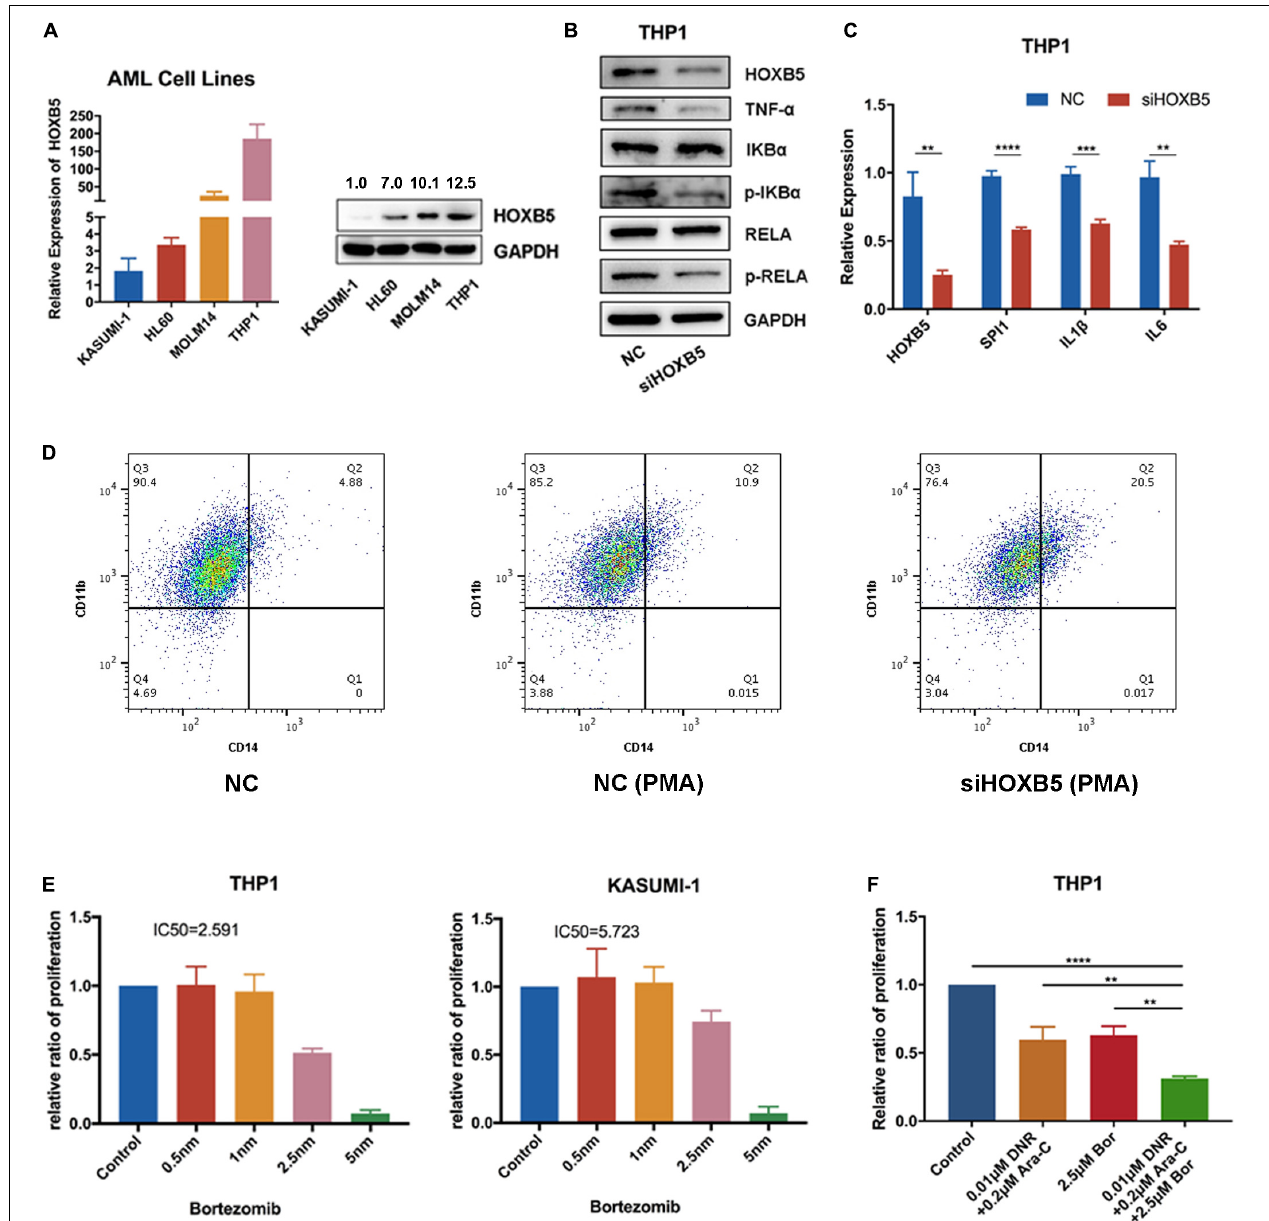
FIGURE 4 | HOXB5 participates in myeloid cells differentiation by regulating TNF/NF- κ B pathway. (A) HOXB5 expression differences in four AML cell lines. (B) The expression changes of TNF/NF- κ B pathway related genes after HOXB5 knockdown confirmed by Western blot in THP1. (C) The expression changes of NF- κ B–targeted genes after HOXB5 knockdown confirmed by RT-qPCR in THP1. (D) The cell differentiation changes of THP1 after PMA treatment between NC and siHOXB5 group. (E) The sensitivities of bortezomib in THP1 and KASUMI-1 (48 h). (F) The synergism effect of bortezomib and chemotherapy agents (daunomycin and cytarabine) in THP1 cells (48 h). ** P < 0.01, *** P < 0.001, and **** P <